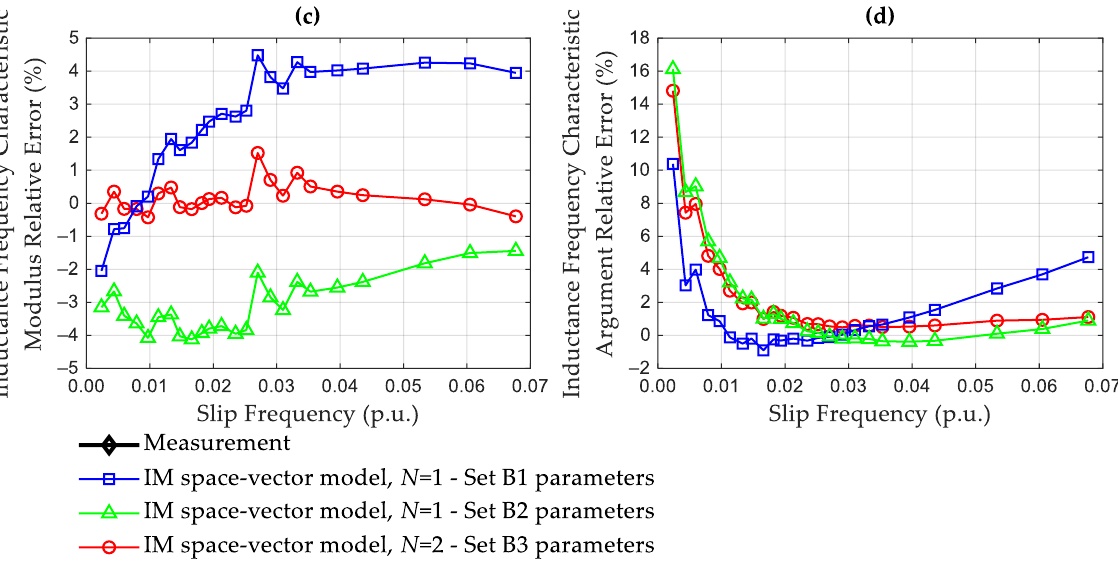
Figure 4. The CR IM inductance frequency characteristic and its approximation by the space vector models: ( a ) modulus; ( b ) argument; ( c ) modulus relative errors; and ( d ) argument relative errors. The data obtained from the load curve tests additionally serve to determine the current slip characteristics of the tested IMs which are presented in Figure A1 (Appendix A). These characteristics indicate the slip frequency ranges considered under the parameter identification process for the space vector models including the rotor deep-bar effect and under the verification tests of the MRAS- based speed estimators’ performance.